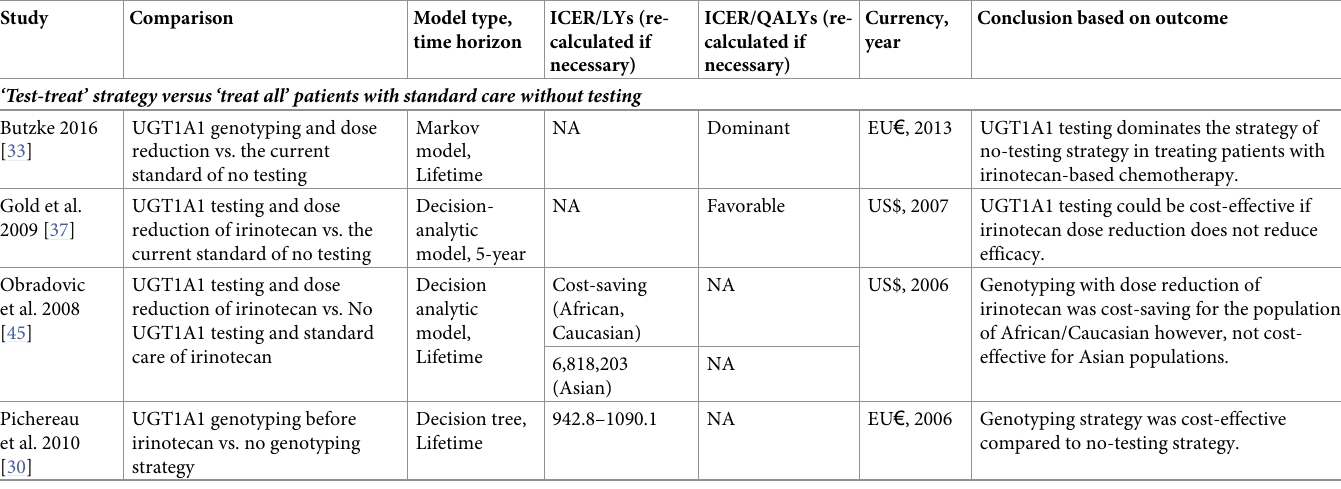
Table 3. Cost-effectiveness of UGT1A1